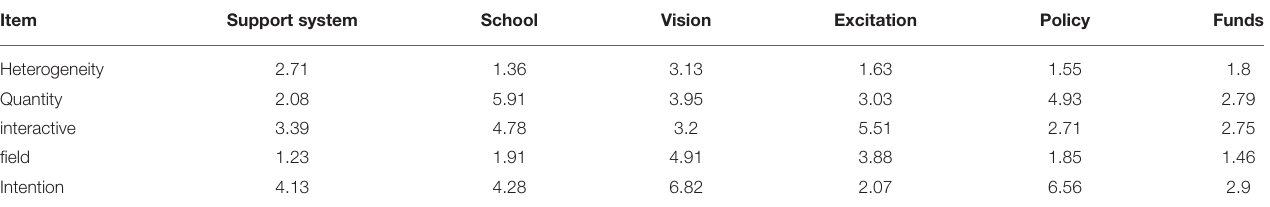
TABLE 7 | Innovative atmosphere and the influence of English learning